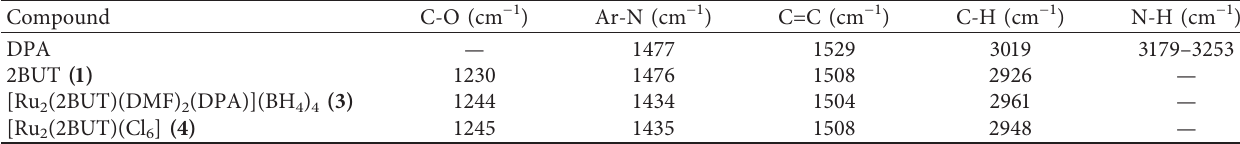
Table 1: FTIR assignments for ligands and complexes.